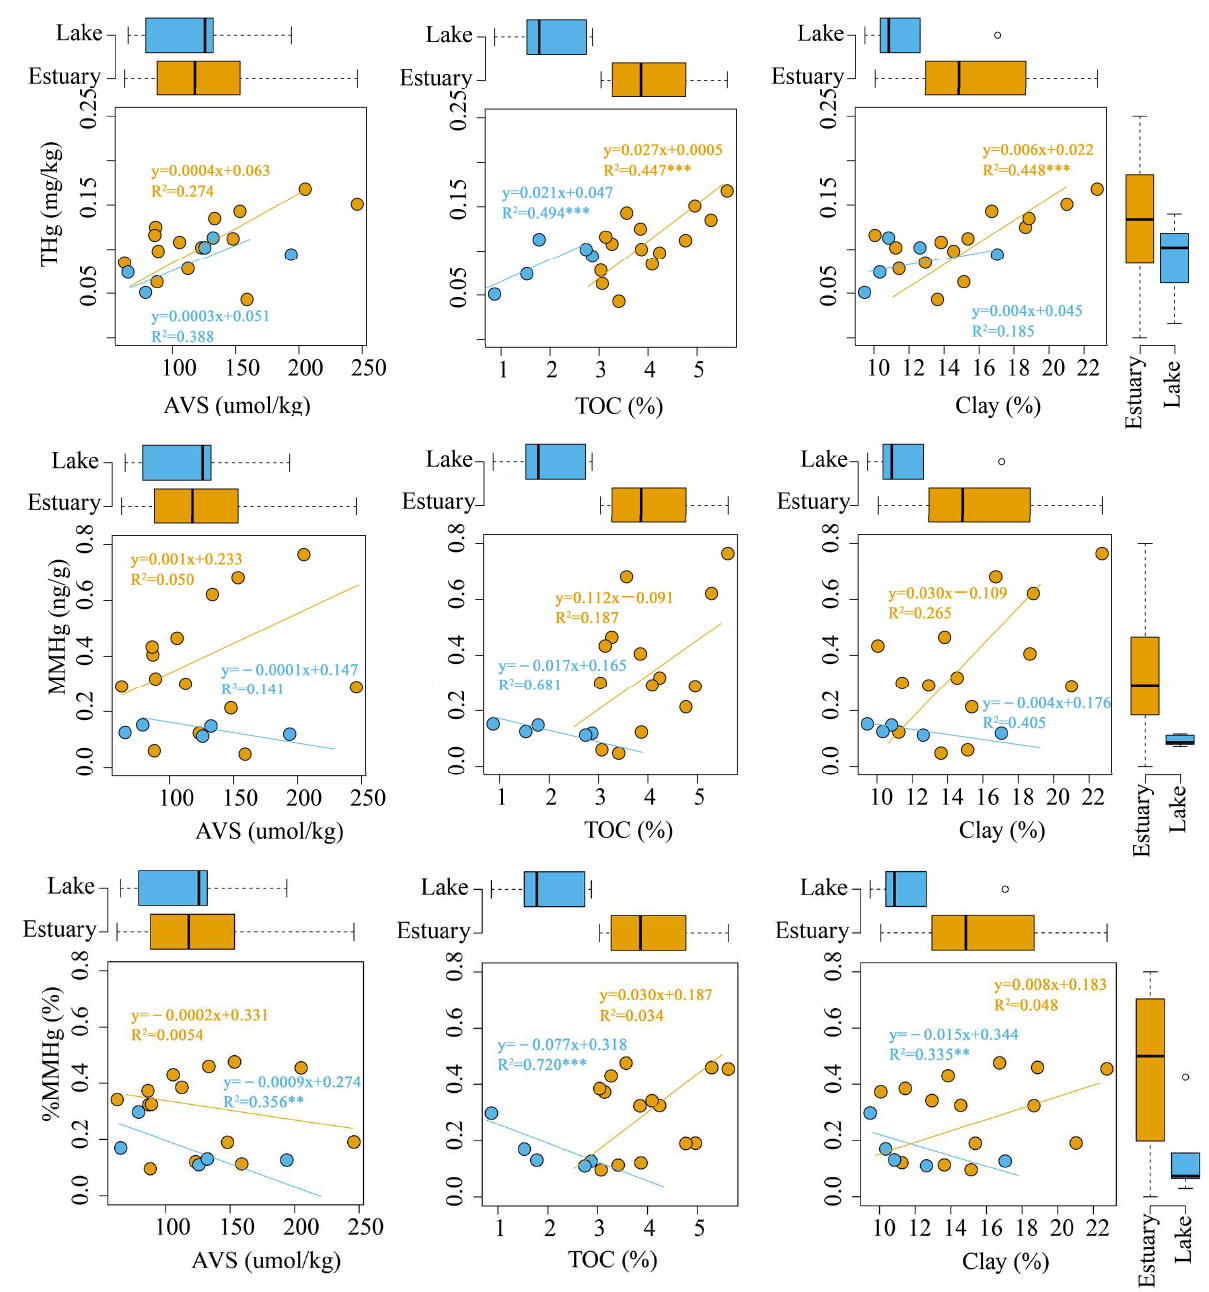
Figure 5. Correlation between THg, MMHg, and %MMHg and sediment properties. Blue dots represent sampling sites for lakes, while yellow dots represent sampling sites for estuaries. The box chart represents the concentration range of various substances in the lake or estuary, the lines in the box represent the average value, the bottom and top of the box represent the 25th and 75th percentile quantile, and the short lines at both ends represent the maximum and minimum values. ** represented significant level p < 0.01, and *** represented significant level p <